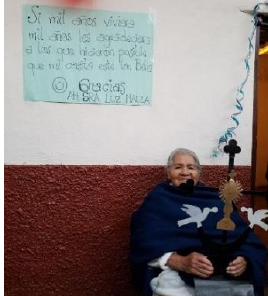
Figure 3. Etelvina Gallegos, neighbor. Source: University Agenda, August